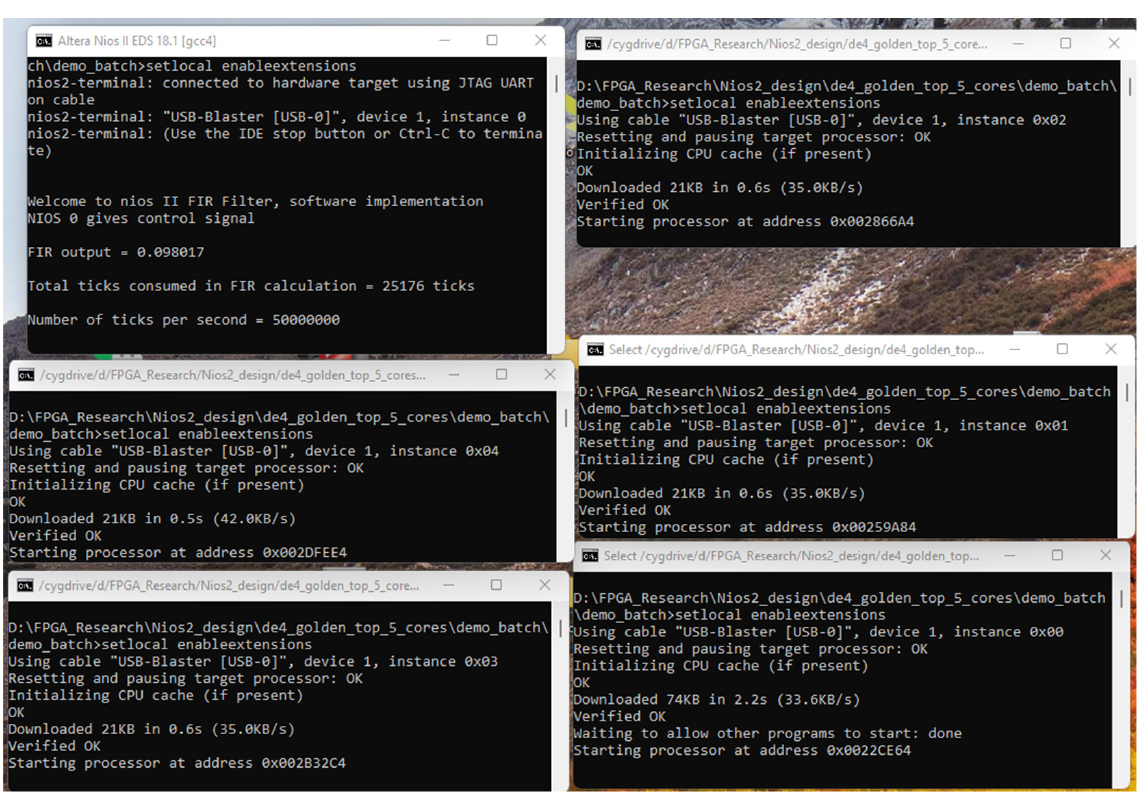
Figure 17. The pseudocode of the DOS setup.